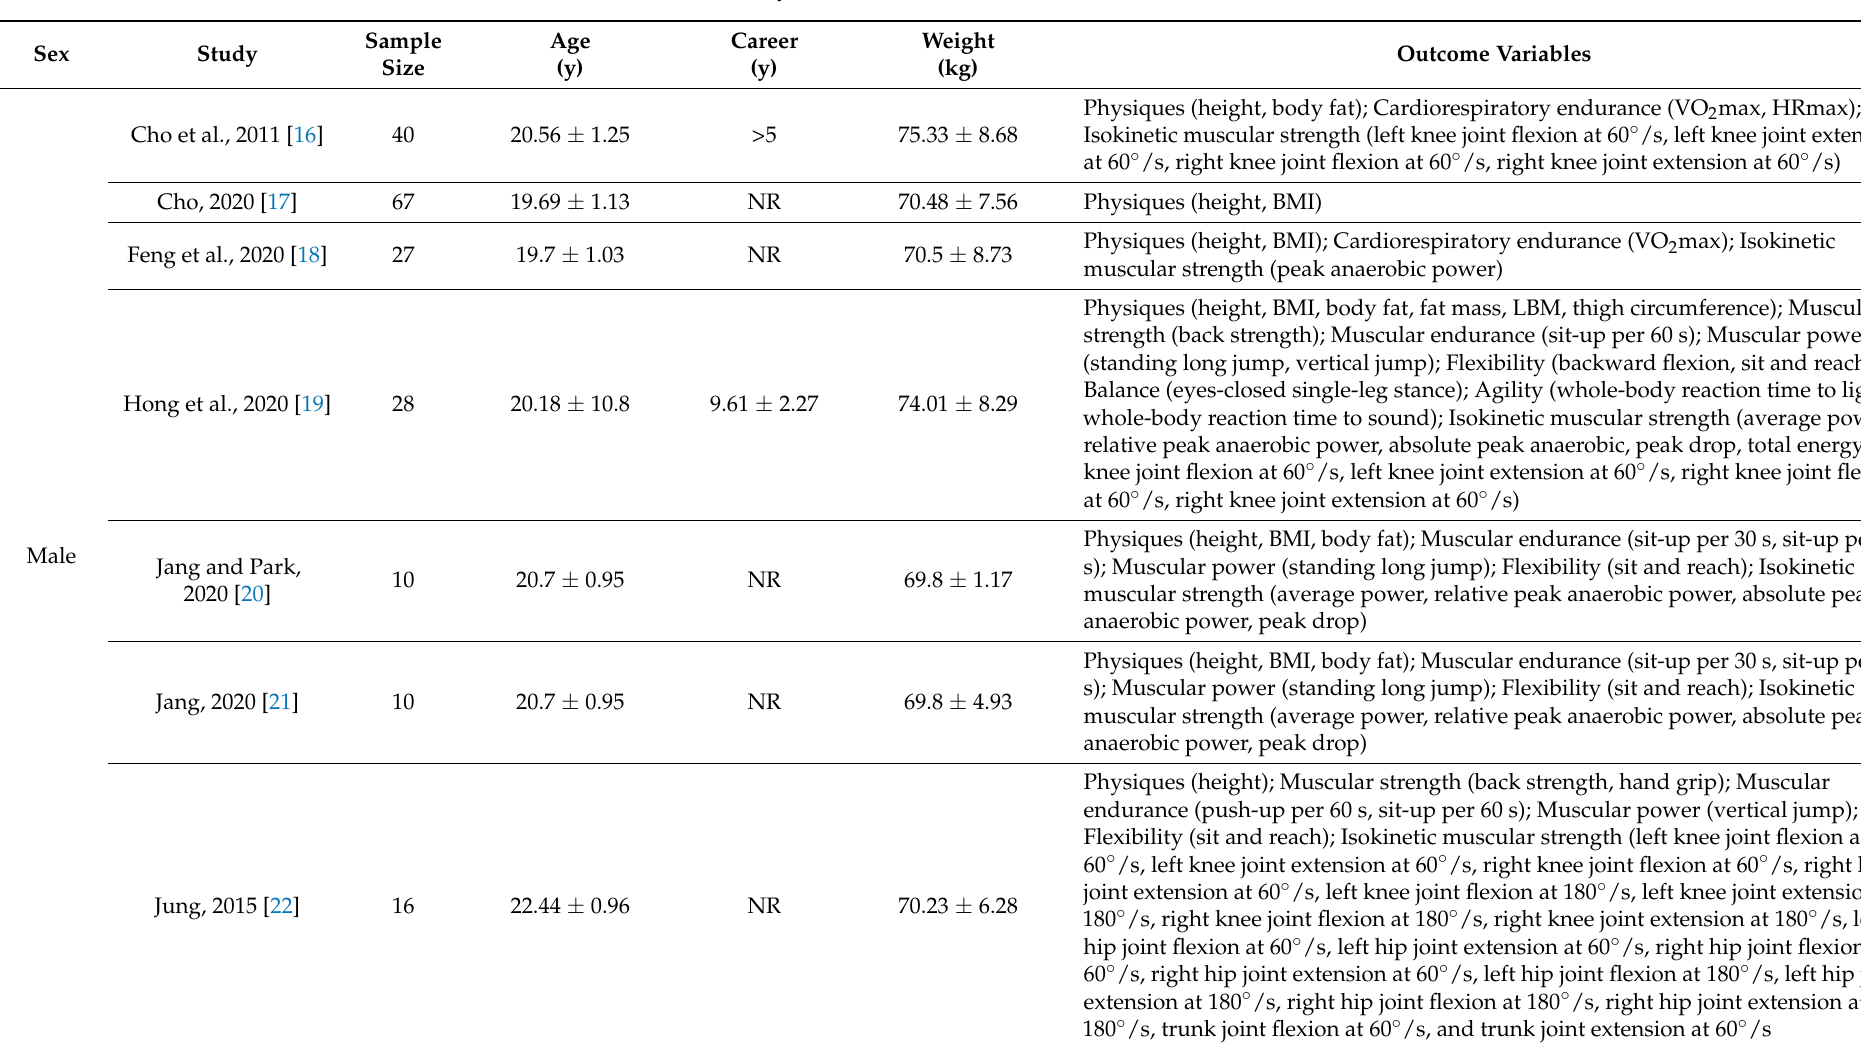
Table 2. Study characteristics and extracted outcome